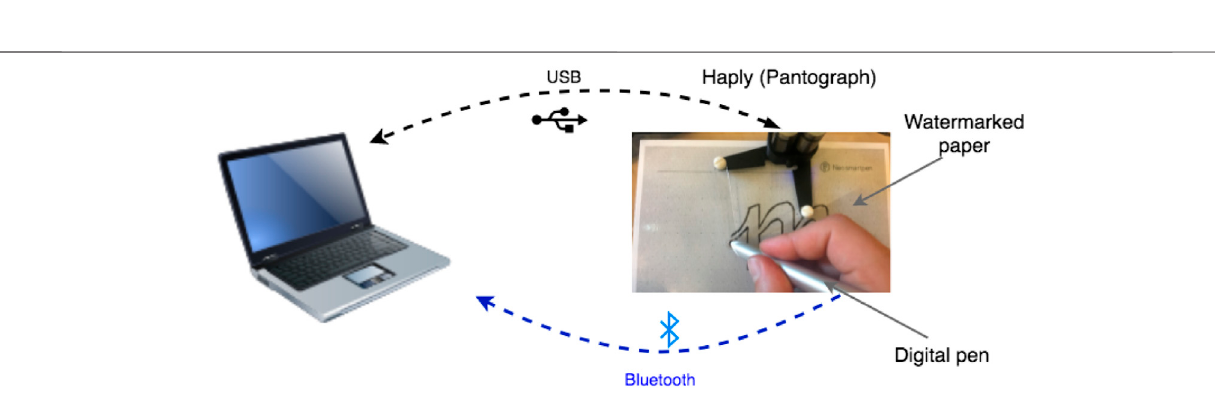
FIGURE 2 | Technical implementation required to support Design (green) and Explore (blue) learning activities in response to ongoing user input. Details are explained in Section 4.3. (The user ’ s graphic from Can Stock Photo, with permission).